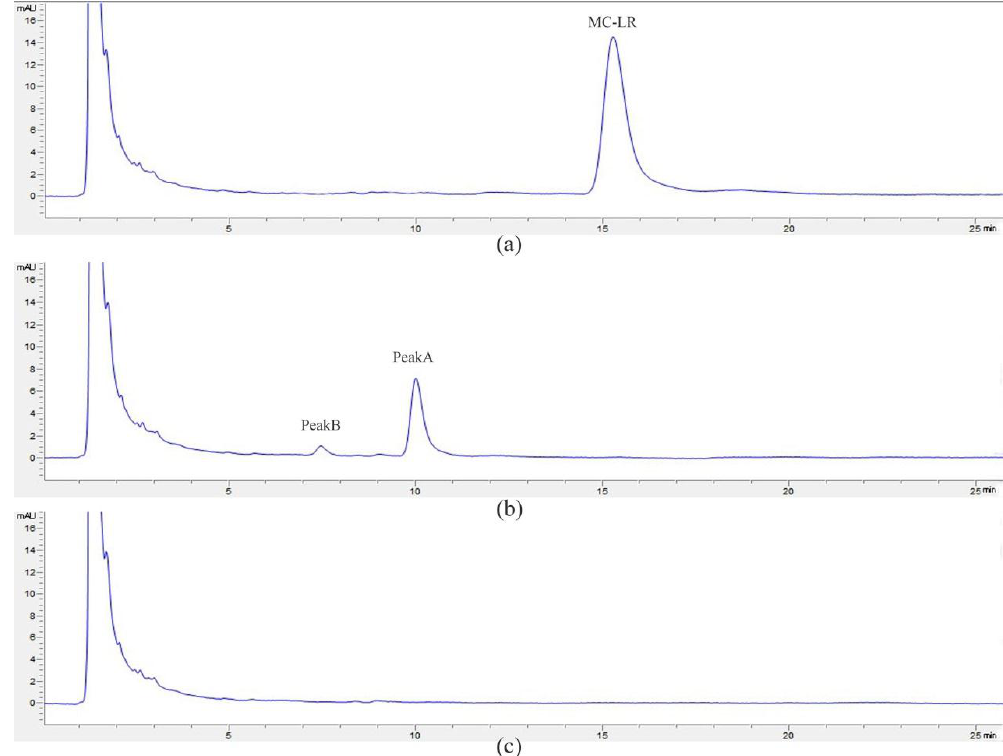
Figure 6. Degradation of standard microcystin LR using strain a7. High-performance liquid chromatography chromatogram at ( a ) 0, ( b ) 6 h, and ( c ) 12 h. Peaks A and B show two intermediate products of MC-LR.